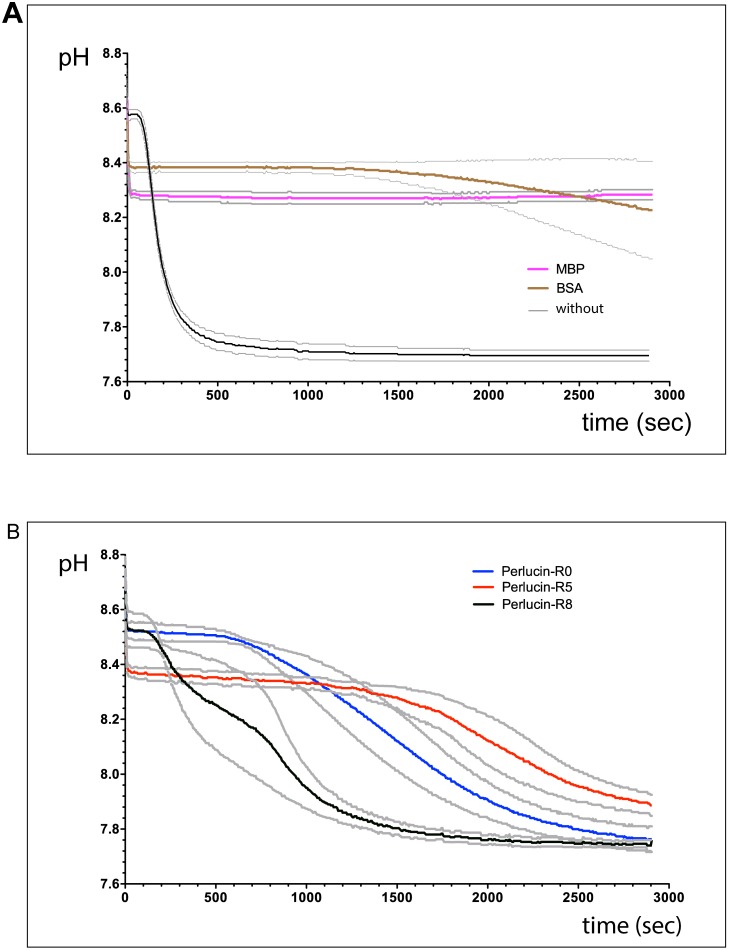
Enhancement of CaCO3 precipitation by MBP-Perlucin.250 µL of 20mM NaHCO3, 500mM NaCl, pH 8.7 containing 100 µg/mL of the indicated protein were mixed with 250 µL 20mM CaCl2, 500mM NaCl, pH 8.7 and the pH was recorded to monitor CaCO3 precipitation as described in the Methods section. The average pH values of three independent measurements (coloured) with standard deviations (grey) are shown. A) Control reactions with MBP (pink), BSA (brown), or without protein (black). B) MBP-Perlucin-R0 (blue), MBP-Perlucin-R5 (red), MBP-Perlucin-R8 (black).